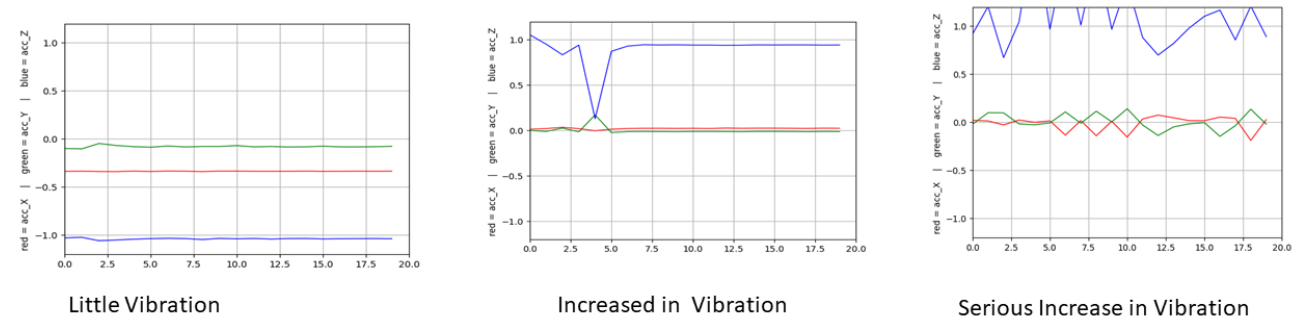
Figure 2. Vibration sensor connection to the host computer using the universal serial bus (USB) gateway. Visualization and saving of data is achieved with the sensorconnect software.